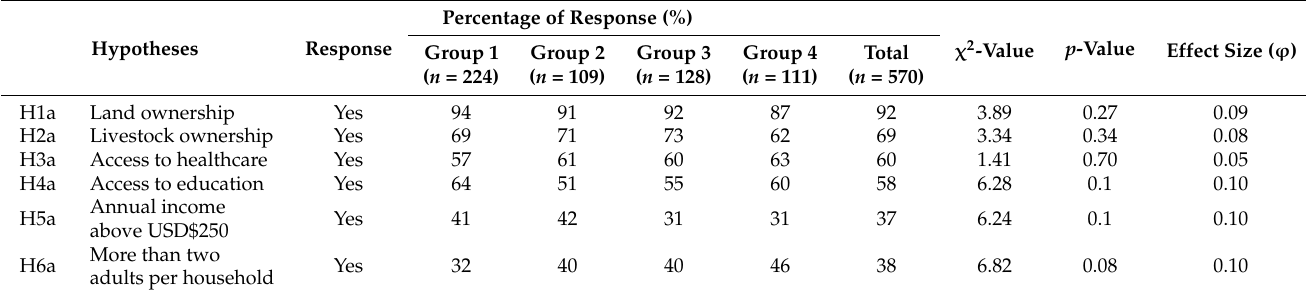
Table 4. Ownership of livelihood assets across varied types of tourism-related livelihood